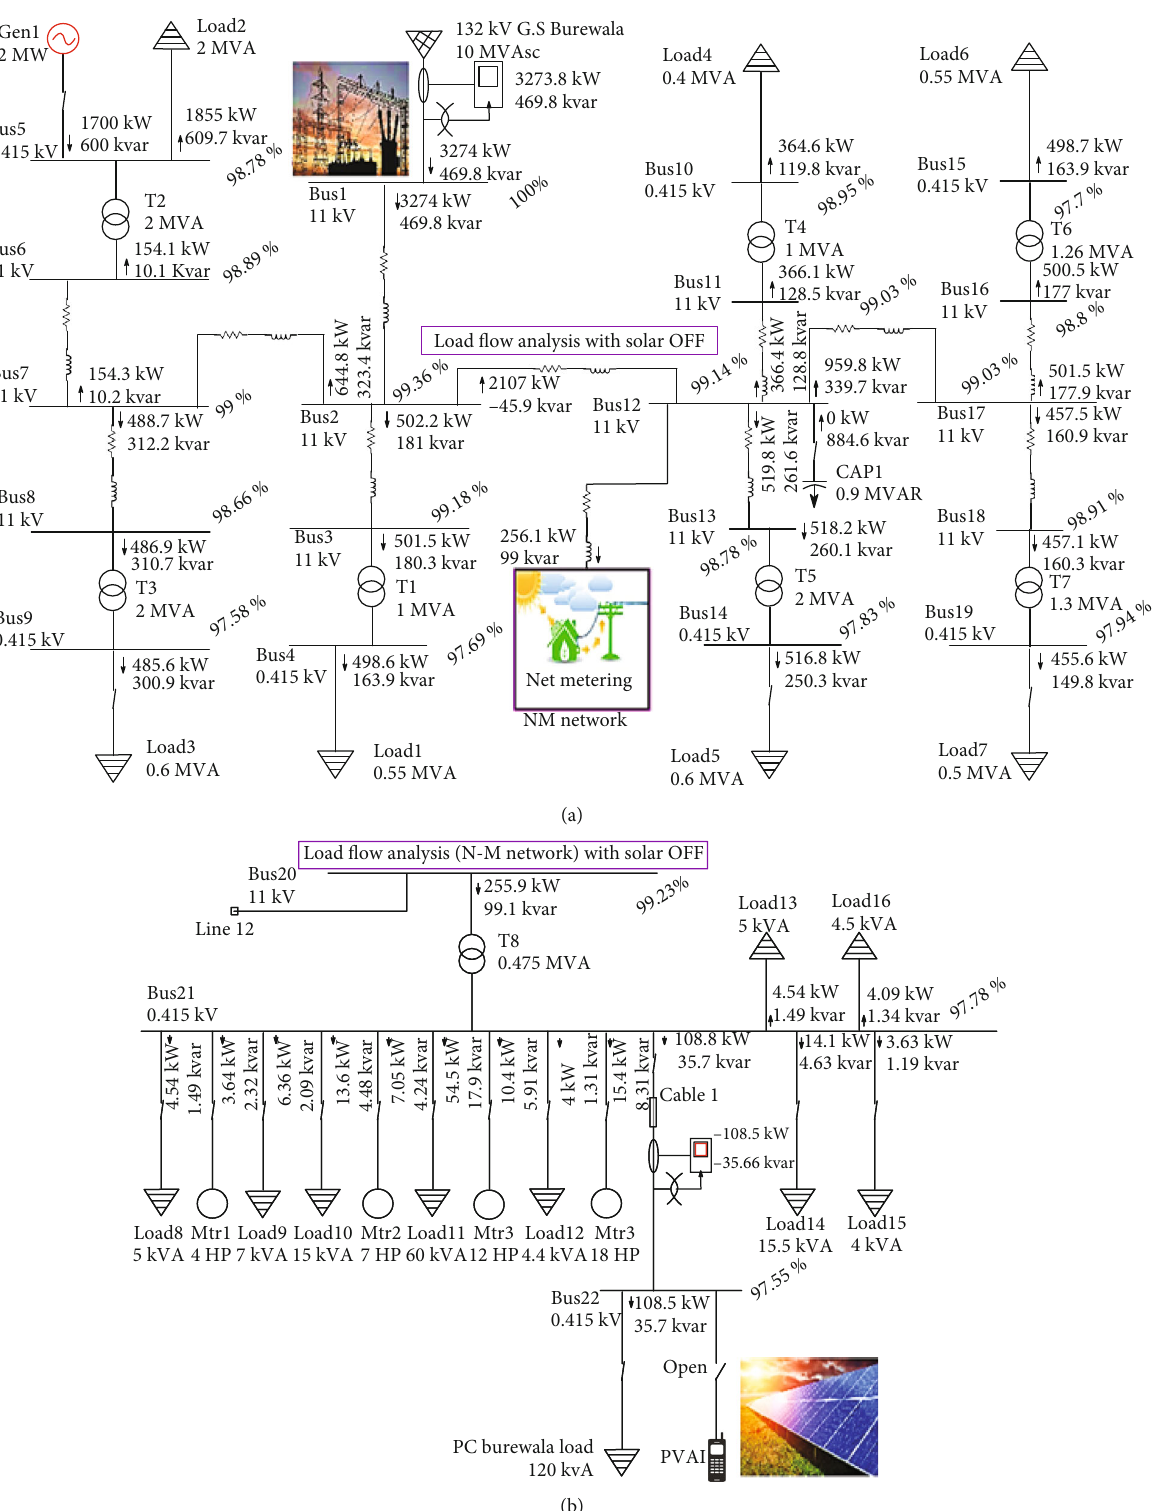
Figure 3: (a) Load fl ow analysis with Bus22 load ON/solar power OFF. (b) Load fl ow analysis (N-M network) with Bus22 load ON/solar oower